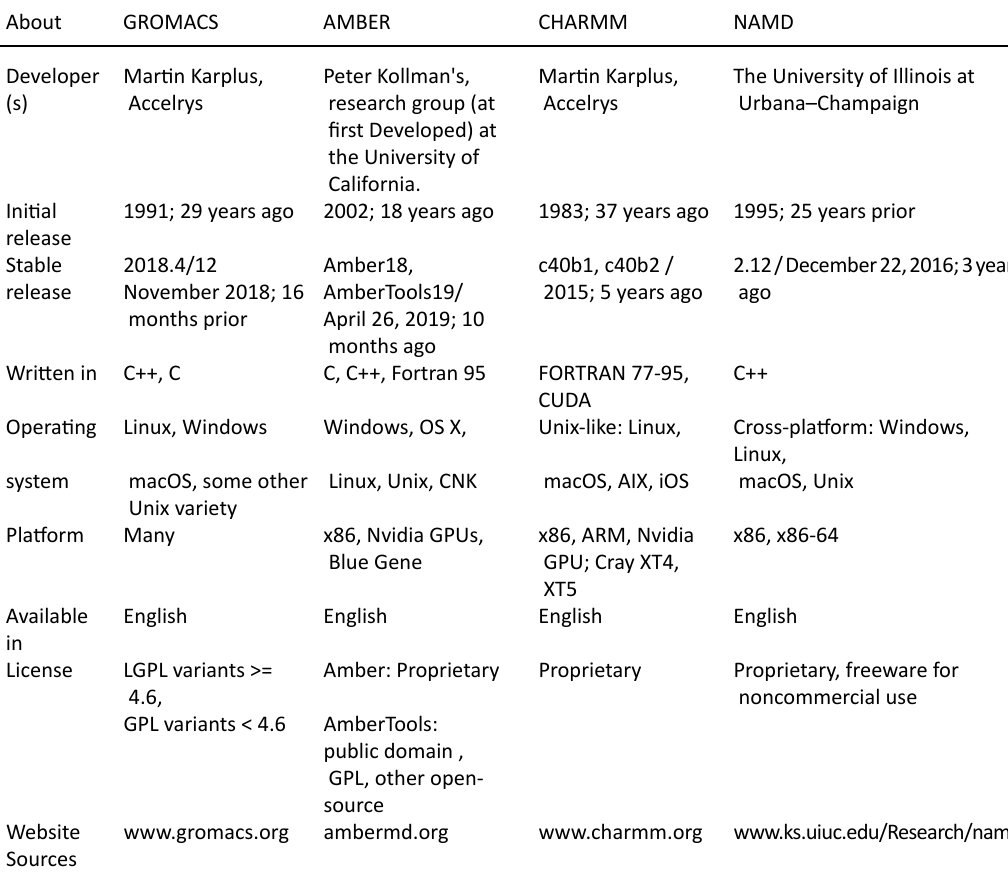
Table 6. List of major Software and tools for MD Simulation